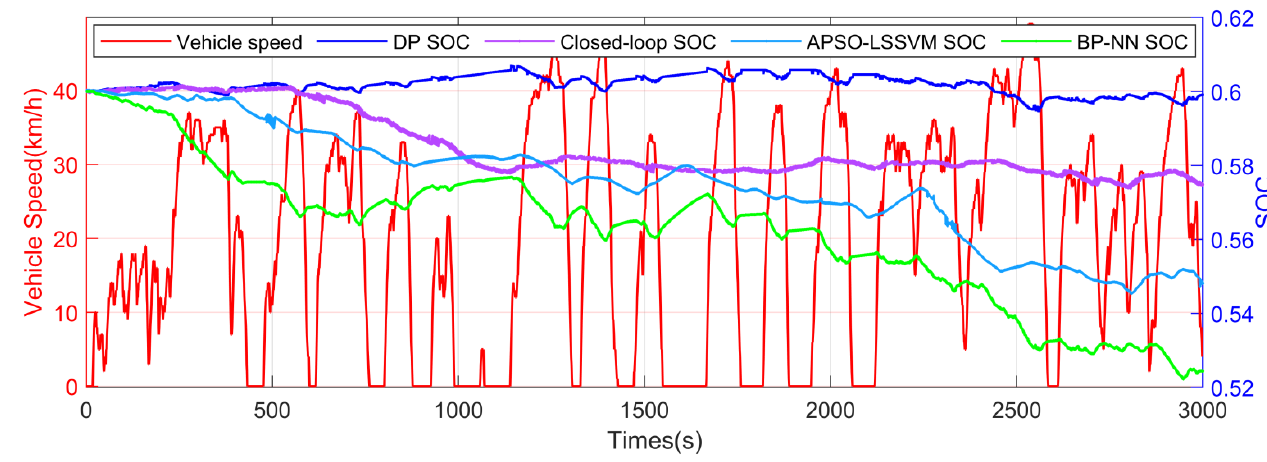
Energies 2022 , 14 , x FOR PEER REVIEW 16 of 18 Figure 11. State of charge of SOC with vehicle speed. Figure 11. State of charge of SOC with vehicle speed.